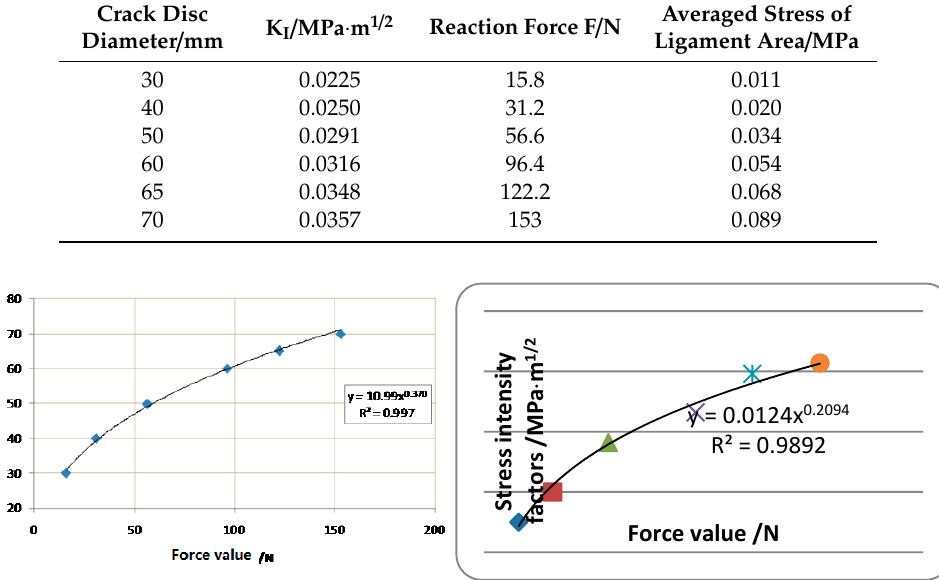
Figure 18. The finite element model. Table 5. Result of numerical analysis by Finite Element Method.